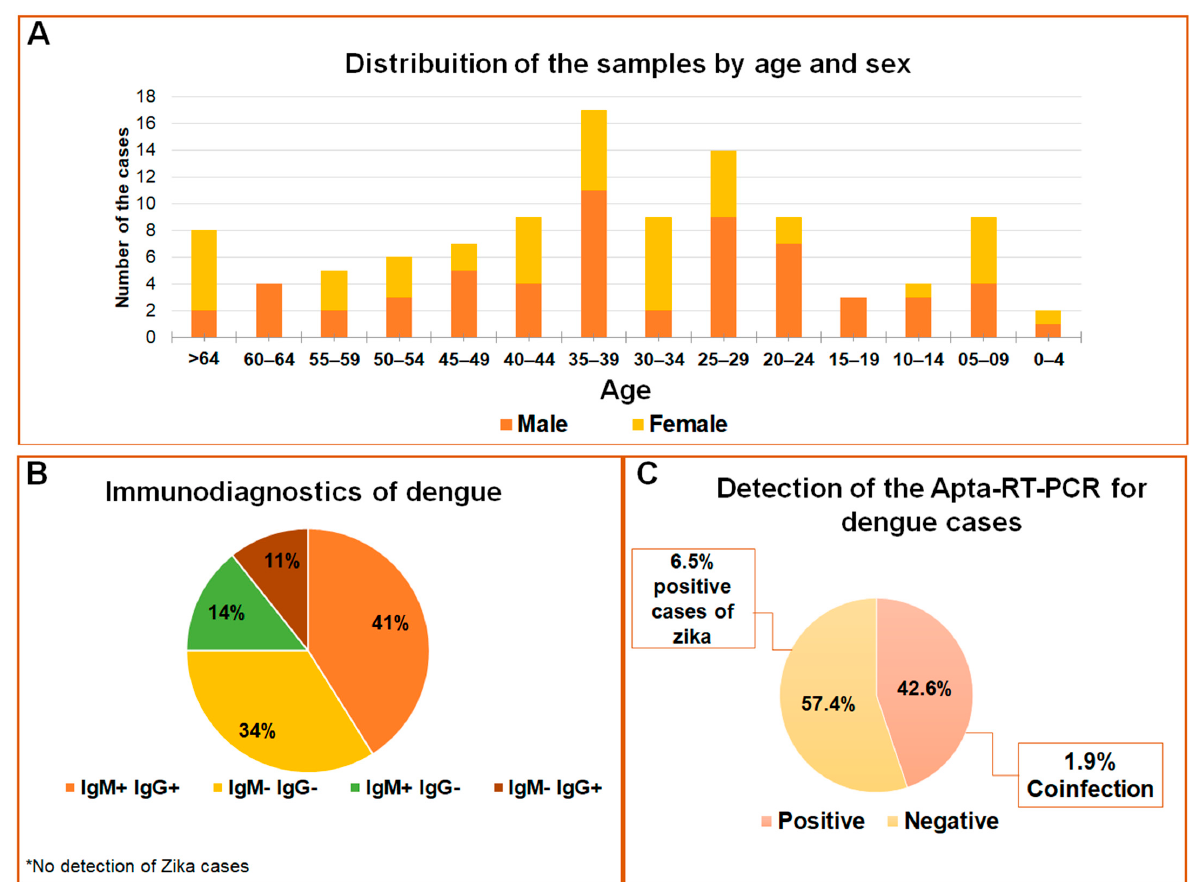
Figure 5. Profile of flavivirus detection in serum samples. ( A ) Population distribution according to age and sex of the individuals; ( B ) Distribution of the data according to IgM and IgG serological reactions; ( C ) Detections for DENV and ZIKV by APTA-RT-PCR in the studied population.